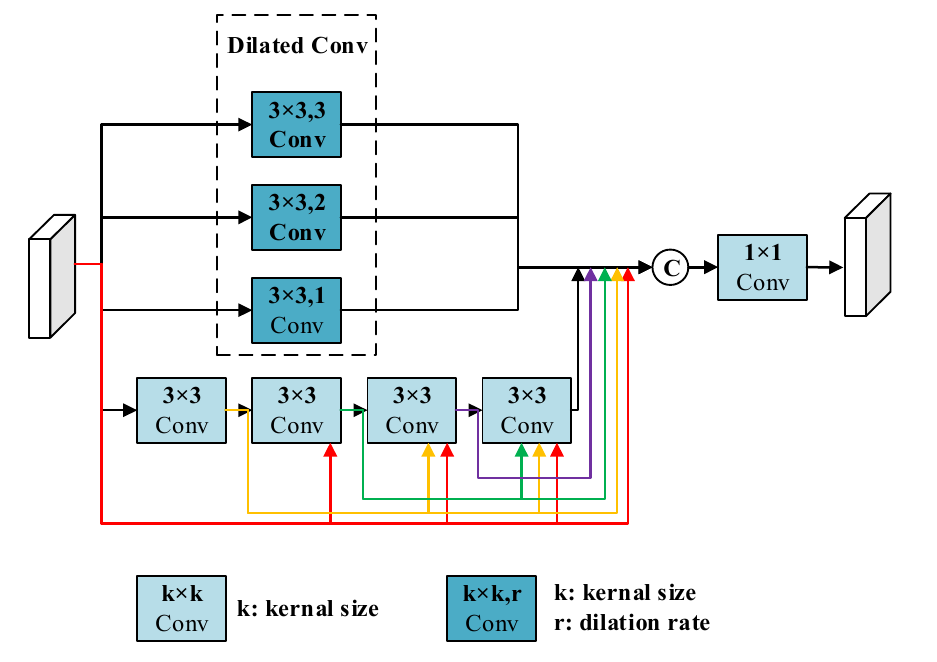
Figure 2. The structure of the MDM.